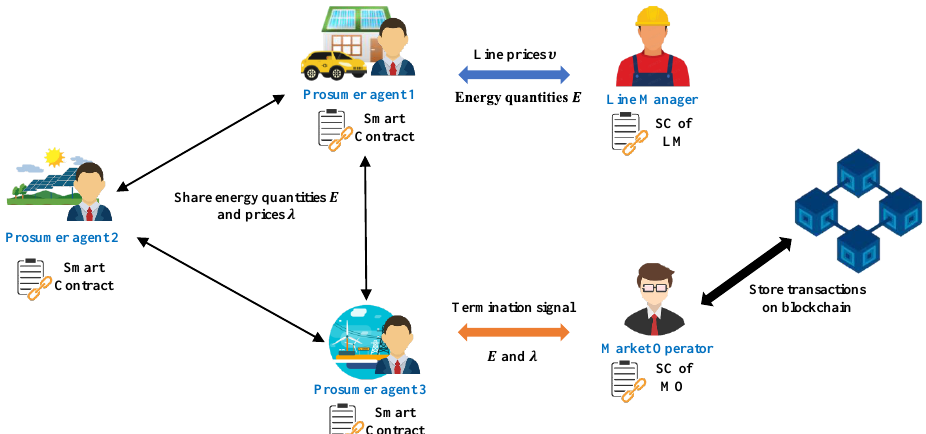
Figure 2. Blockchain-based P2P energy-trading market